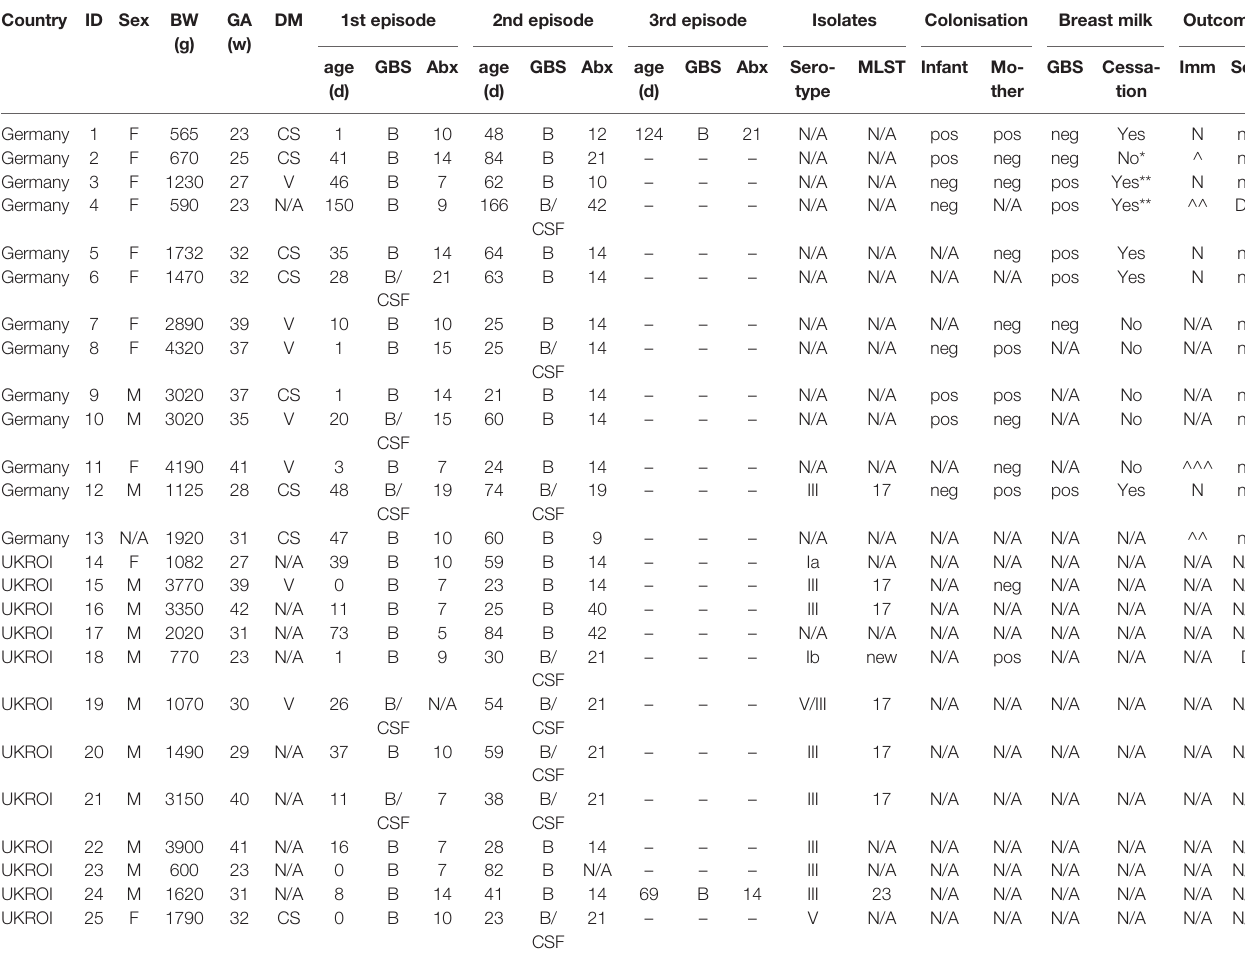
TABLE 2 | Clinical features of cases of recurrent GBS